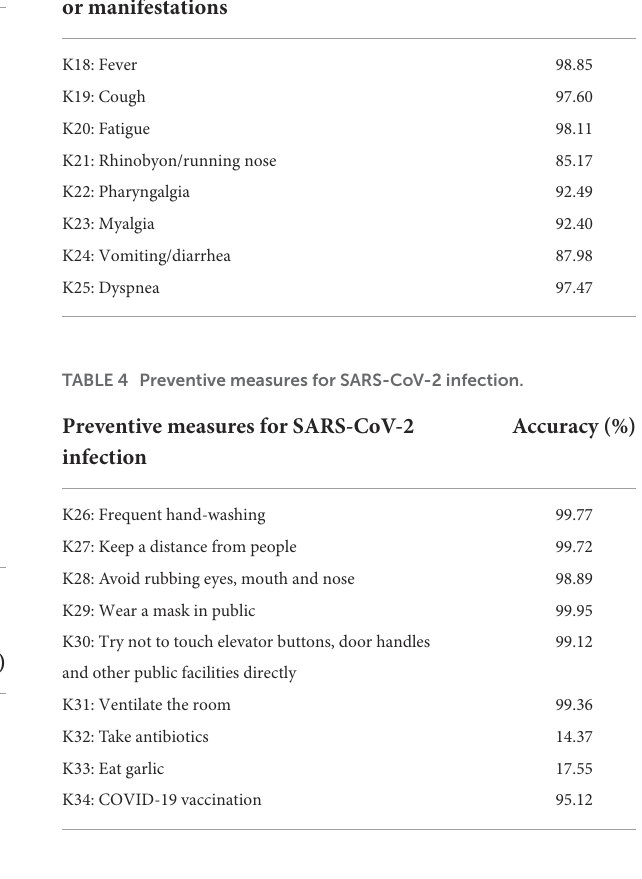
TABLE 3 Symptoms and manifestations of COVID-19 infection.